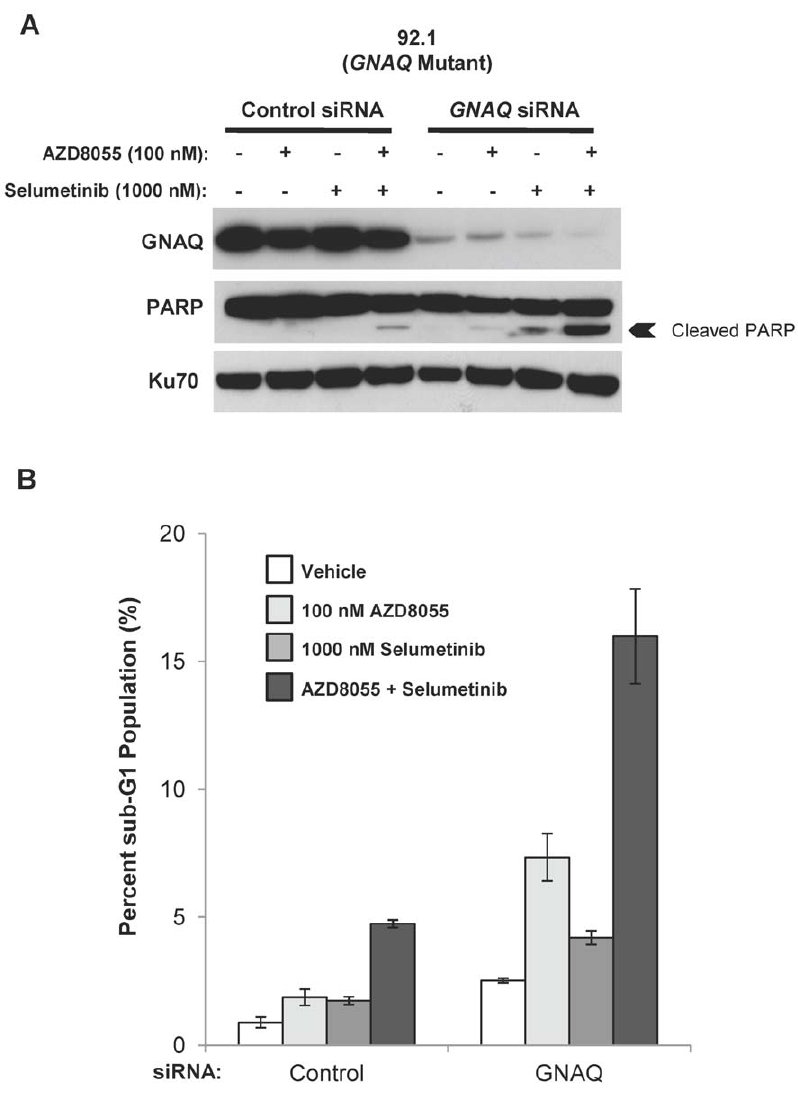
Figure 3. Suppression of GNAQ expression in GNAQ mutant cells augments AZD8055/selumetinib-induced apoptosis. A, suppression of GNAQ expression in the GNAQ mutant cell line 92.1 with pooled siRNA constructs resulted in increased PARP cleavage with the AZD8055/ selumetinib combination. 92.1 cells were transfected with pooled GNAQ targeting siRNA constructs or unrelated control constructs for 24 hours and then treated with drugs for 24 hours (vehicle (denoted by ‘‘-’’), 100 nM AZD8055, 1000 nM selumetinib, or the combination). Cell lysates were created and Western blots were then performed. The nuclear protein Ku70 was used as a loading control. B, suppression of GNAQ expression increased the sub-G1 population induced by the AZD8055/selumetinib combination in 92.1 cells. Cells were treated as detailed in A and then analyzed by flow cytometry for DNA content. The percentage of sub-G1 cells was quantified. Results are the mean of two independent experiments. Error bars, SE.